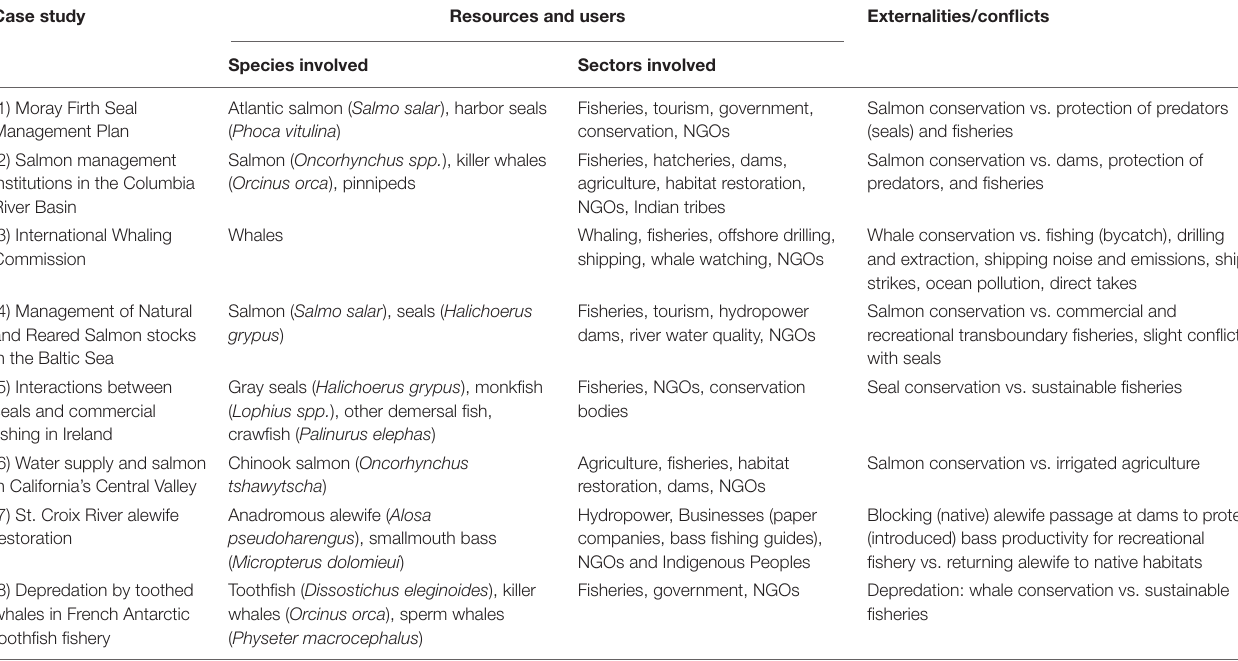
TABLE 3 | Case studies – conflict characterization.